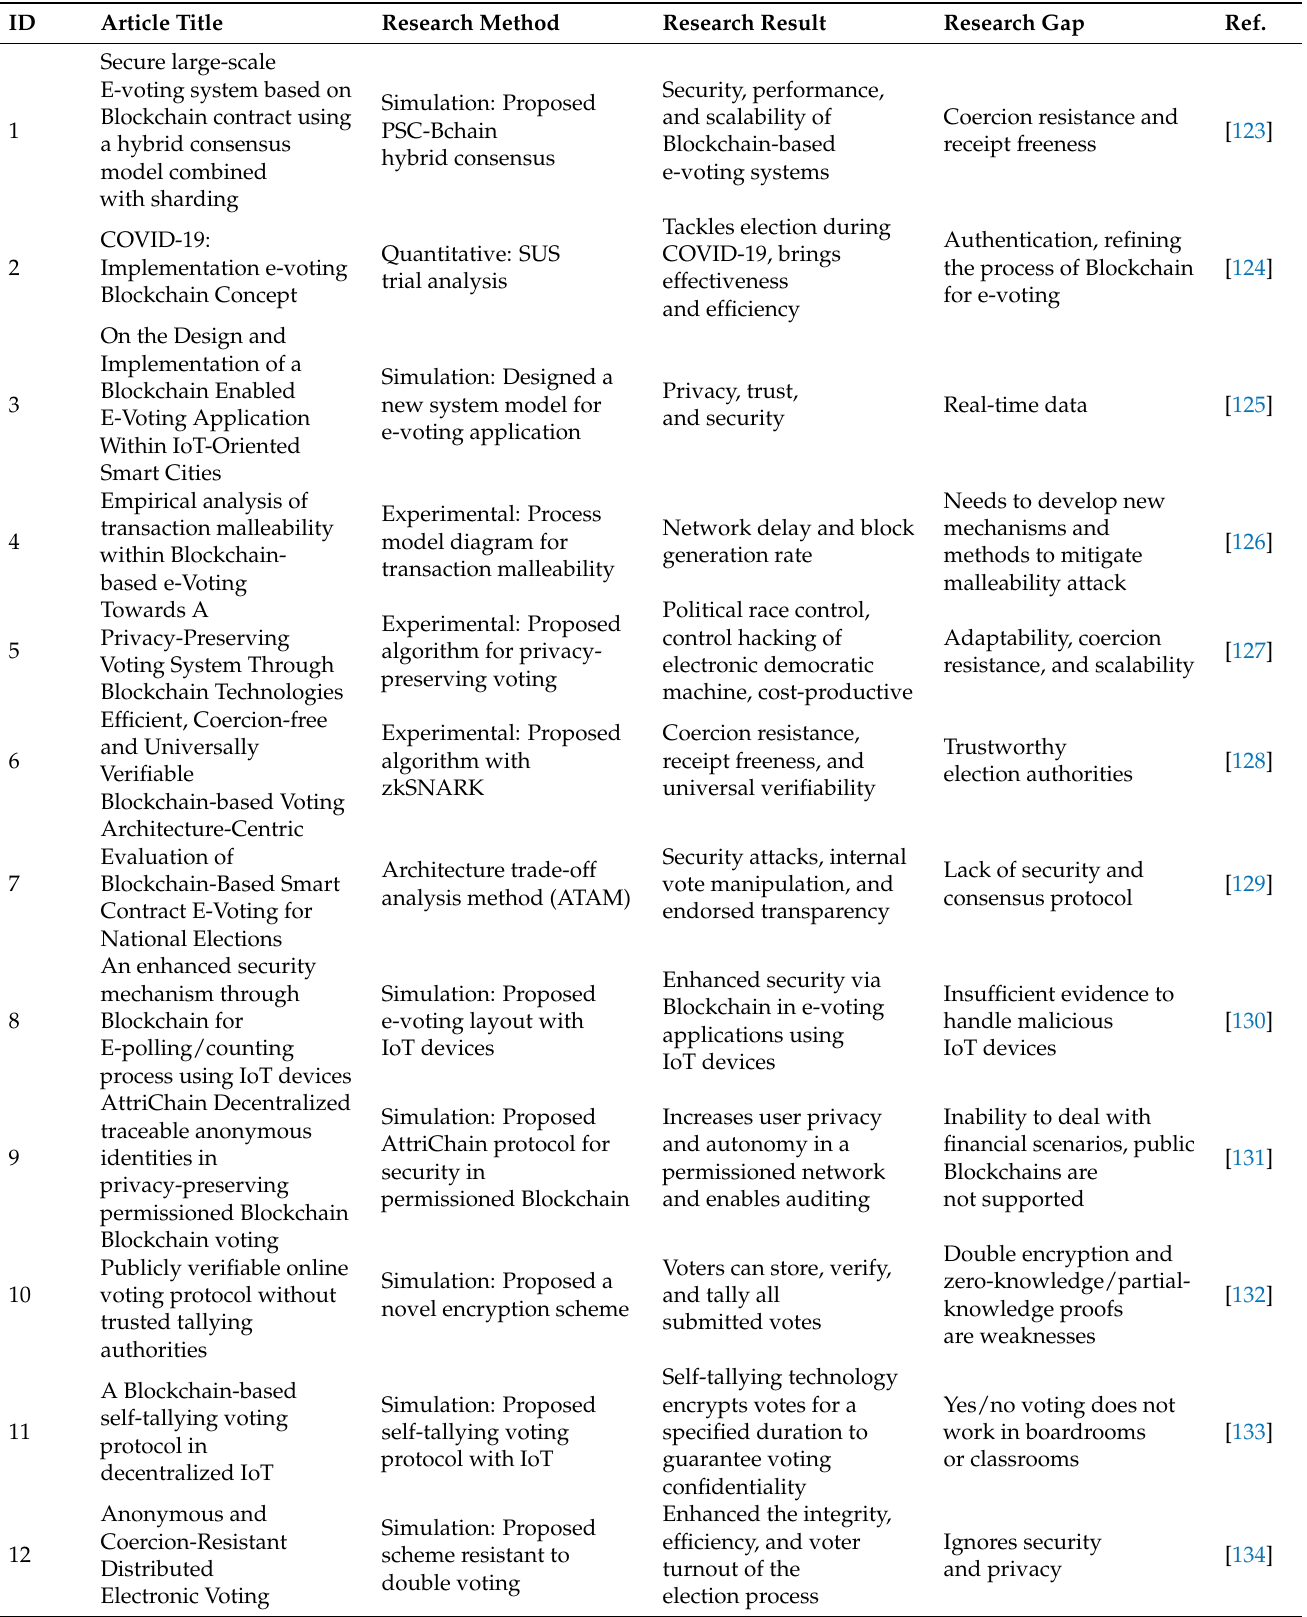
Table 8. Papers about Blockchain for electronic voting selected for